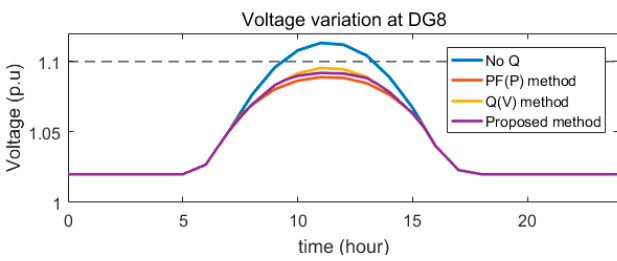
Figure 14. Voltage variation at DG8 with di ff erent reactive power control Figure 13. Voltage variation at DG8 with different reactive power control methods.